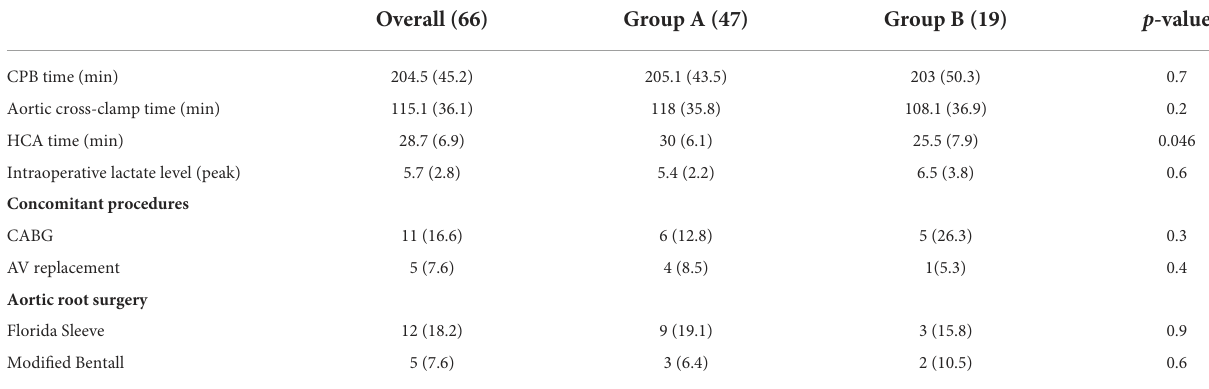
TABLE 2 Operative characteristics.